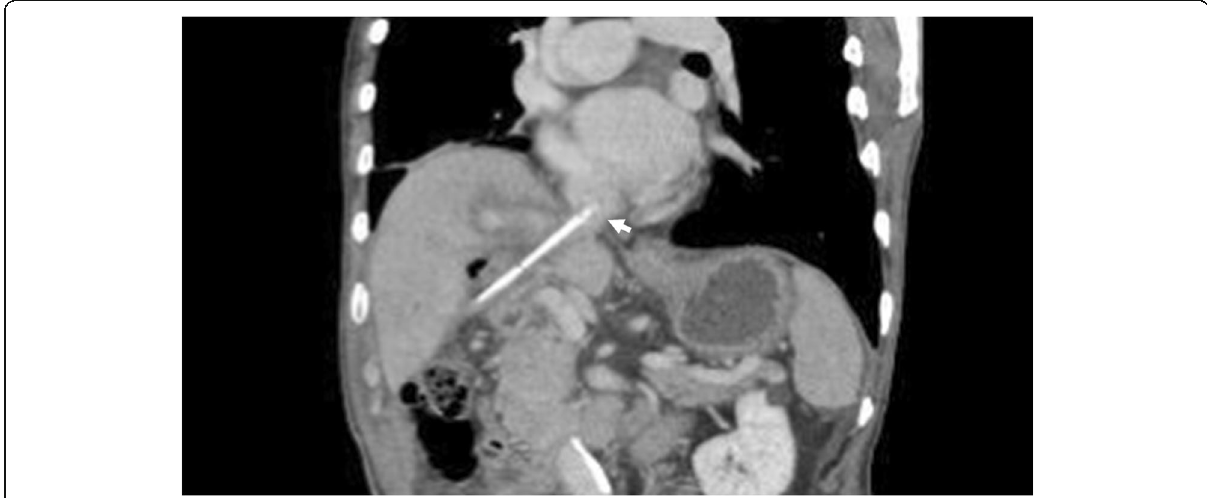
Fig. 4 An enhanced abdominal CT scan showed the tip of the drain perforating the IVC and straying into the RA (arrow). IVC inferior vena cava, RA right